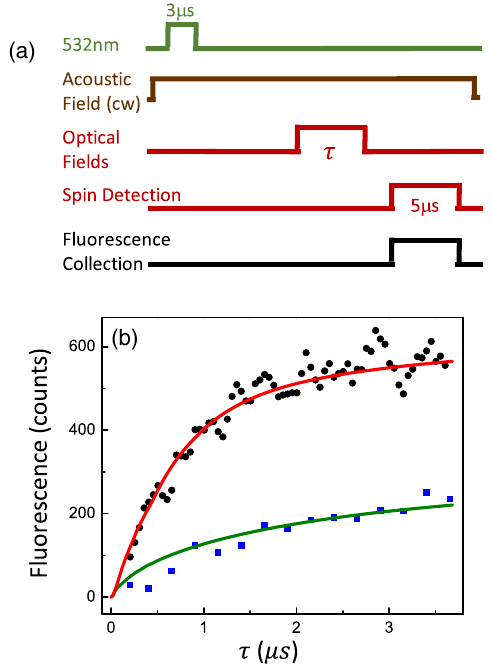
FIG. 6. (a) Pulse sequence used for the transient sideband spin transition experiment. (b) Fluorescence from state A 2 as a − function of the optical pulse duration. Solid circles: ω 0 þ ω m ω (cid:2) satisfies the Raman resonant condition for the sideband spin − ω transition. Solid squares: ω 0 þ ω (cid:2) is 6.5 MHz detuned m from the Raman resonant condition (the data are smoothed). The solid lines are the theoretical calculations discussed in the